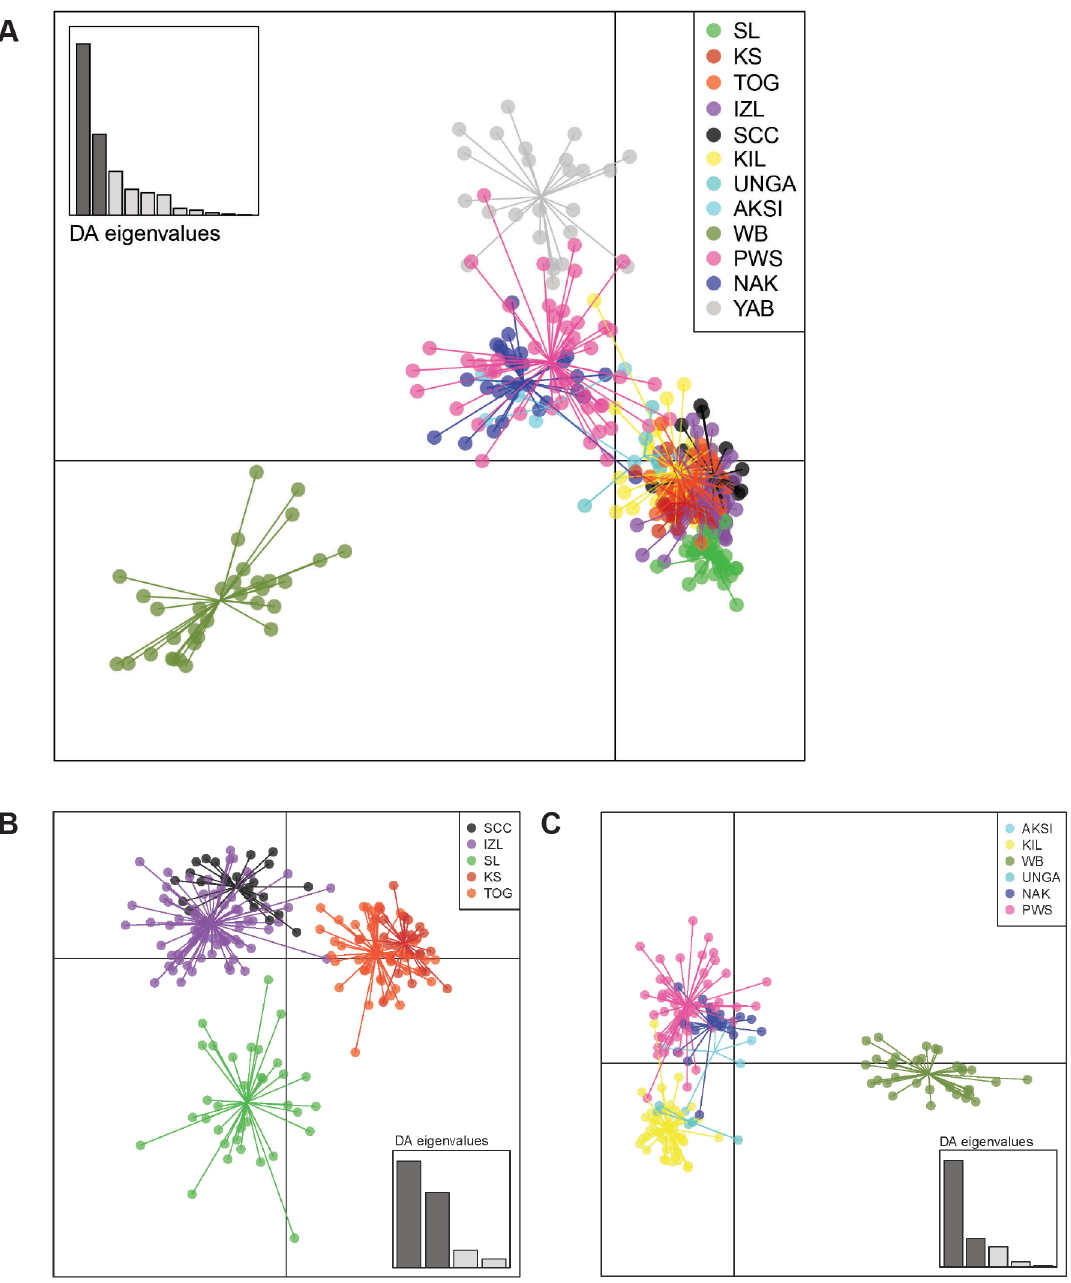
Fig 4. DAPC scatterplots from Z . marina populations in the EBS- and GoA-LMEs. (A) DAPC scatterplot showing genetic variation in all eelgrass populations from both the EBS-LME and GoA-LME. (B) DAPC scatterplot of genetic variation among EBS-LME populations only. (C) DAPC plot of genetic variation among GoA-LME populations only. The first two discriminant functions represent the majority of the genetic variation in each dataset, including 86.5% of the genetic variation among all populations, 91.8% among EBS-LME, and 82.5% among all GoA-LME